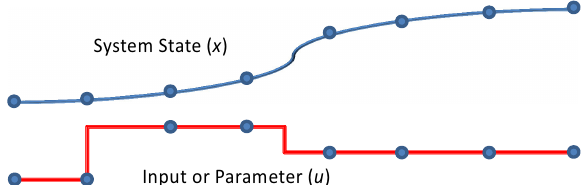
Figure 4. DAEs are discretized and solved over a time horizon with System States ( x ) determined from the equations and Inputs or Parameters ( u ) that may discontinuously adjust at points in the simulated time